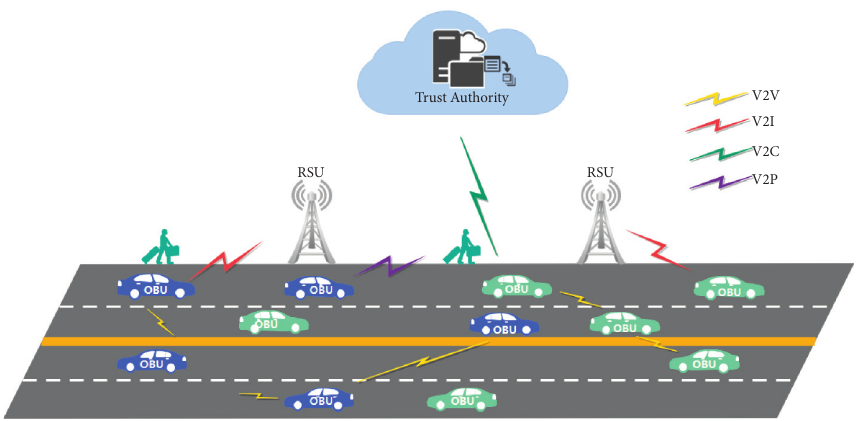
Figure 1: Attacks with corresponding Internet protocol stack